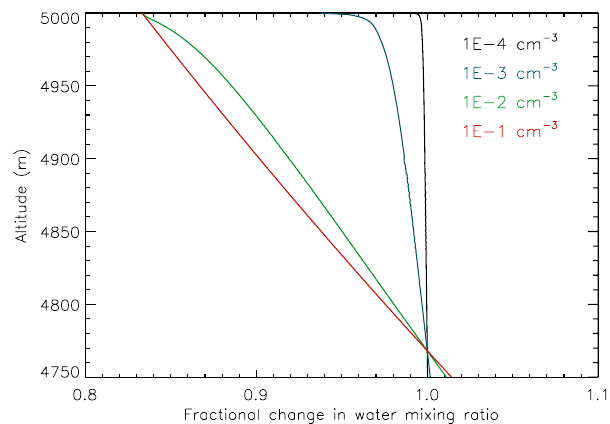
Fig. 10. The fractional dehydration caused by the sedimentation of a 2km thick layer of ice coated ash, with number densities of between 1 × 10 − 4 cm − 3 and 1 × 10 − 1 cm − 3 . Note that number den- sities at or above 1 × 10 − 1 cm − 3 lead to total dehydration of the column. Below 4770m, the column becomes subsaturated, and the sedimenting ice particles begin to evaporate, causing